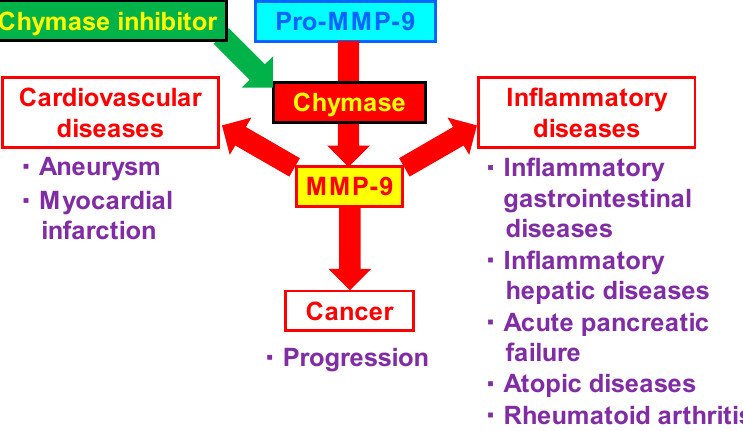
Figure 2. Relationship between MMP-9 and diseases. MMP-9 promotes the cardiovascular diseases such as aneurysm and cardiac remodeling after myocardial infarction. MMP-9 is involved in inflam- matory diseases via the accumulation of inflammatory cells. MMP-9 may also play an important role in the cancer progression via the induction of angiogenesis at the surround of tumor. Chymase inhibitor is a useful strategy to prevent chymase-activated MMP-9.